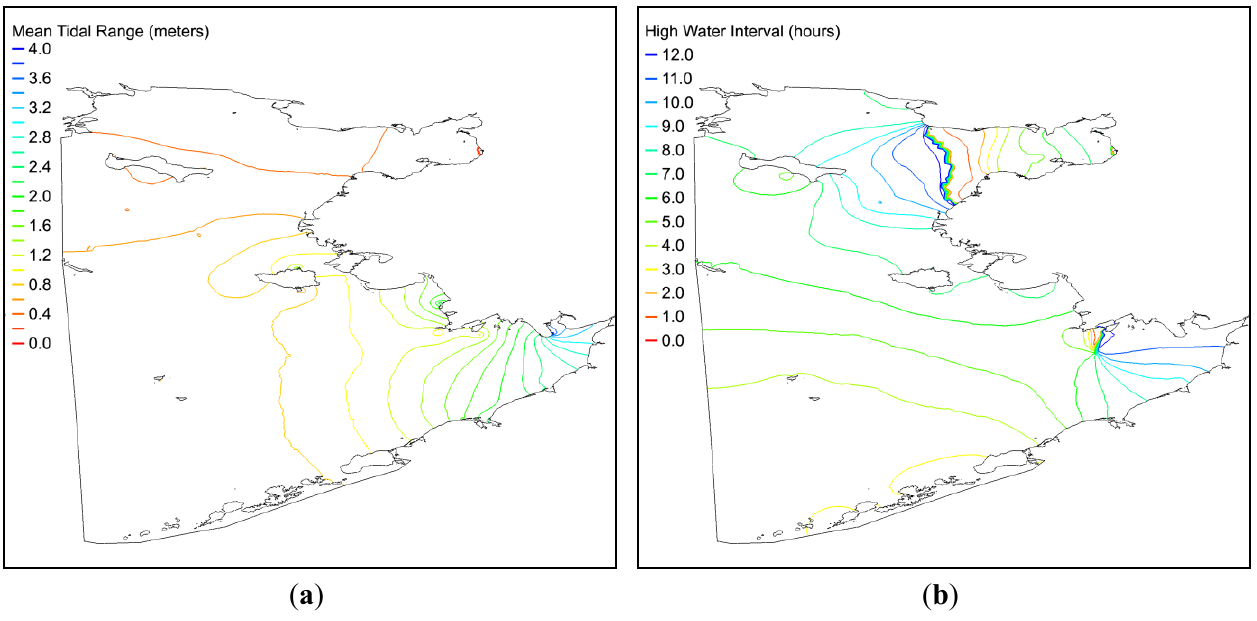
Figure 11. ( a ) The mean tidal range (MN) and ( b ) the high water interval (HWI) derived from TOF harmonic